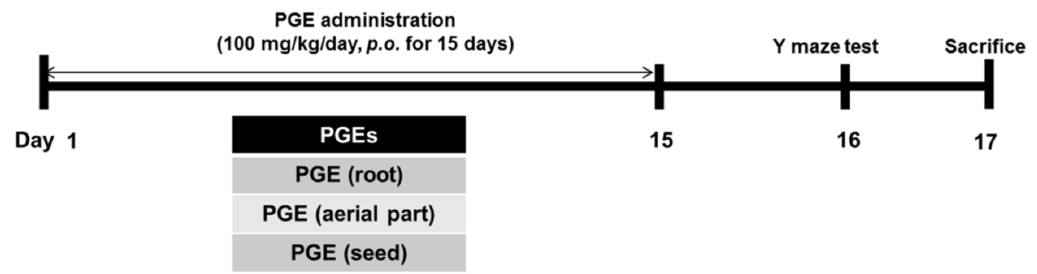
Figure 1. Oral administration of PGEs (100 mg/kg/day) for 15 days. PGEs are classified into three different parts including PGE (root), PGE (aerial part), and PGE (seed). The cognition of mice treated with three different PGEs underwent a Y-maze test. After the behavioral experiment, animals administered with PGE (root) were sacrificed and brains were isolated for analysis. Subsequently, immunohistochemistry of brains was performed using DCX antibody and immunoblotting with SYN antibody. PGE, Platycodon grandiflorus extract. DCX, doublecortin. SYN, synaptophysin.